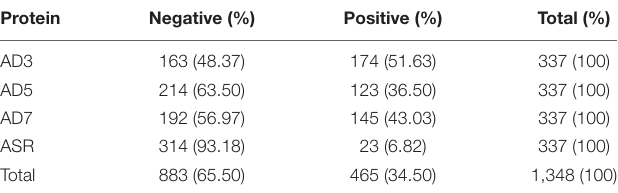
TABLE 7 | Human serum reaction with adenoviral antigen